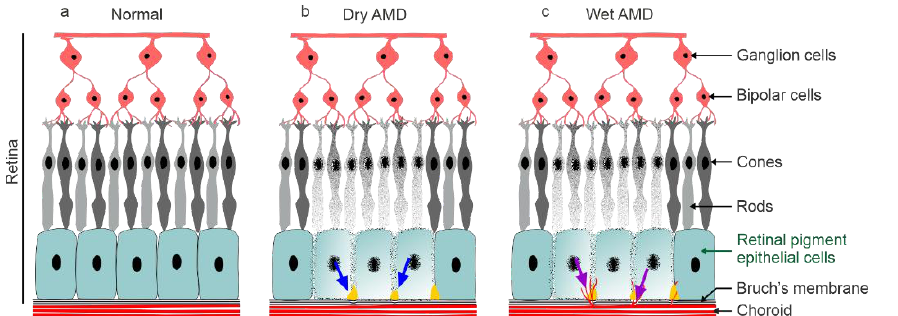
Figure 1. ( a ) A schematic representation of the normal retina; ( b ) dry AMD represents the accumulation of drusen deposits (blue arrow) and the degeneration of RPE cells; ( c ) changes in dry AMD, with choroidal neovascularization (purple arrow) appearing in wet AMD.